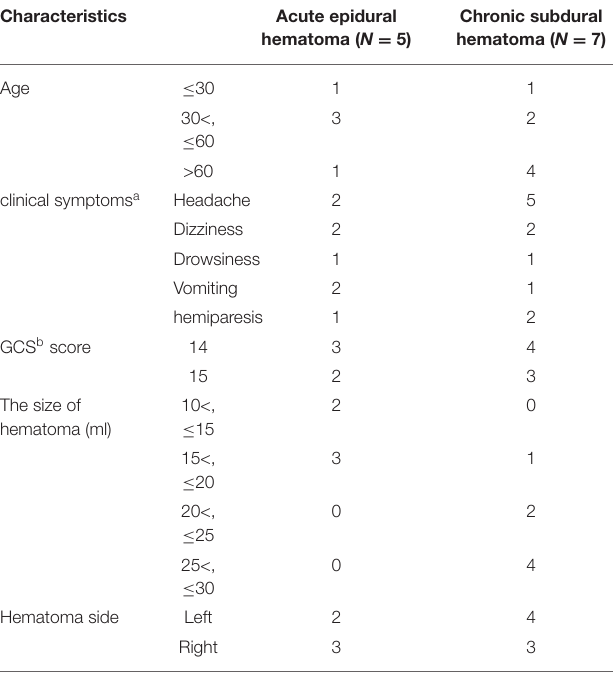
TABLE 1 | Demographic data, clinical and imaging findings of the patients.